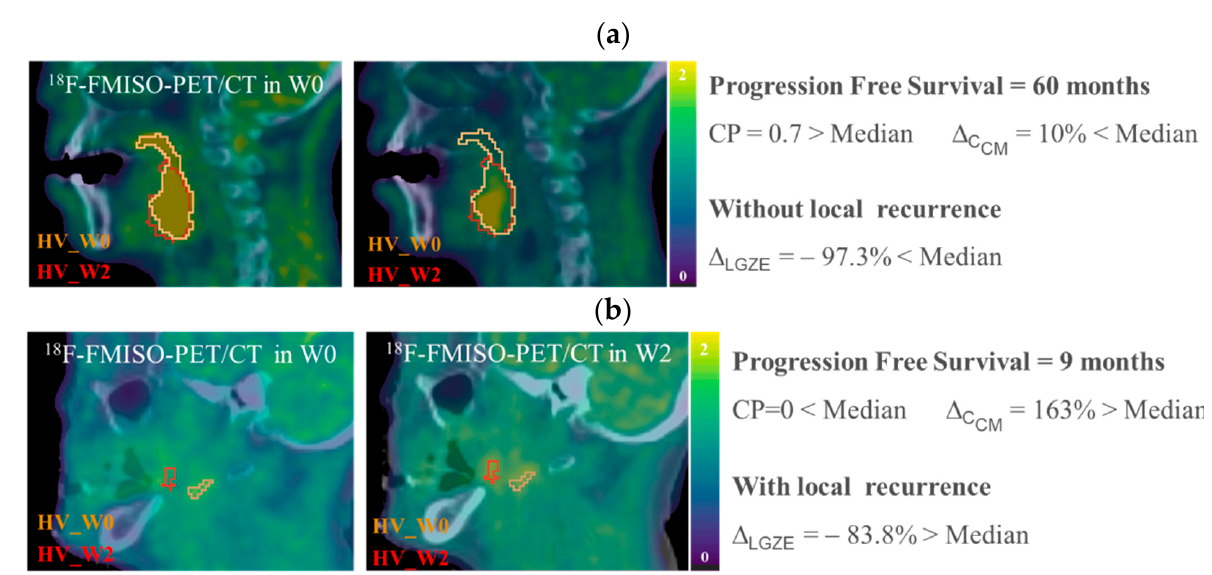
Figure 5. Example of 18 F-FMISO-PET/CT images, HSV contours and values of CP, ∆ C CM and ∆ LGZE , for ( a ) P01, patient without local recurrence and longer progression free survival, and for ( b ) P20 patient with local recurrence and shorter progression free survival. All 18 F-FMISO-PET images were represented with a scale of (0, 2) g/mL and superimposed to the corresponding CT.